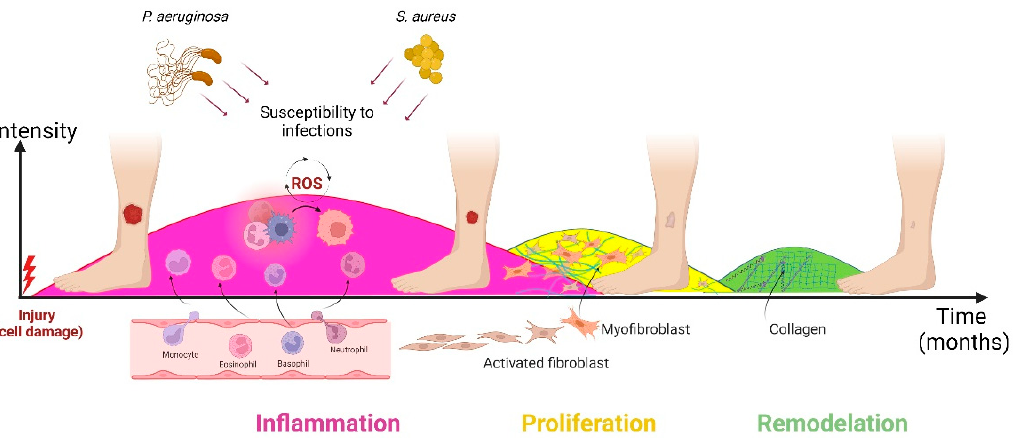
Figure 2. Healing stages of chronic wounds. The migration of phagocytic neutrophils and macrophages to the wound site initiates the inflammatory phase and leads to the release of more cytokines [35]. Oxidative environment due to the continuous production of reactive oxygen species (ROS) and prolonged pro-inflammatory phase promotes infections, and hypertrophic scars with collagen fibers in disorderly arrangement [36,37]. Created with